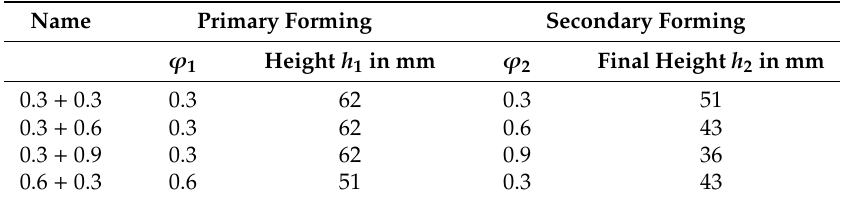
Table 3. Mechanical processing